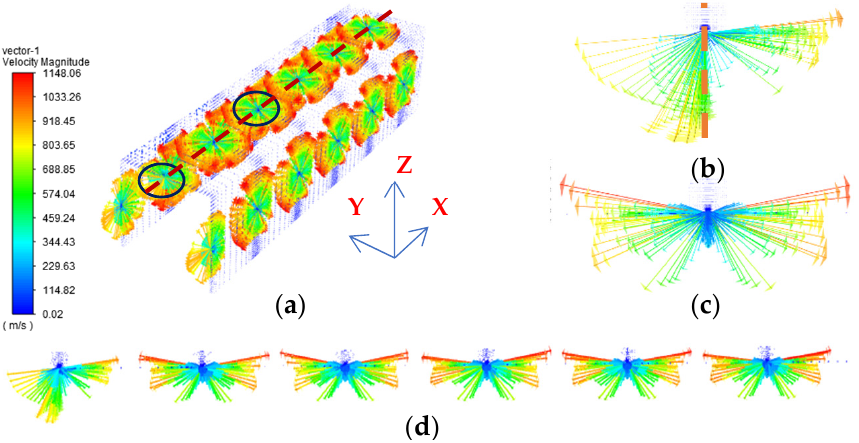
Figure 10. The velocity vector distributions of air films in unbalanced states (0.5 MPa). ( a ) Global view. ( b ) The position near the half-covered throttle hole. ( c ) The position near the fully covered throttle hole. ( d ) The YOZ section of the air film (the highlighted line of the global view). The pressure distribution on the surface with different supply pressure values is